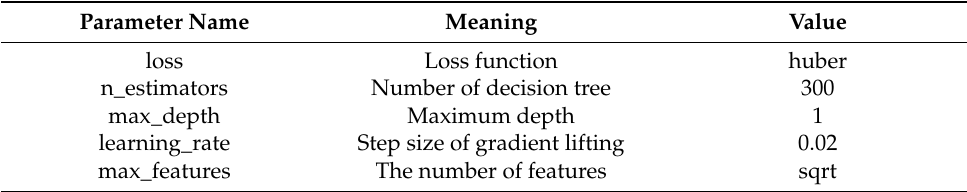
Table 3. Gradient boosting decision tree (GBDT) Parameter Settings.